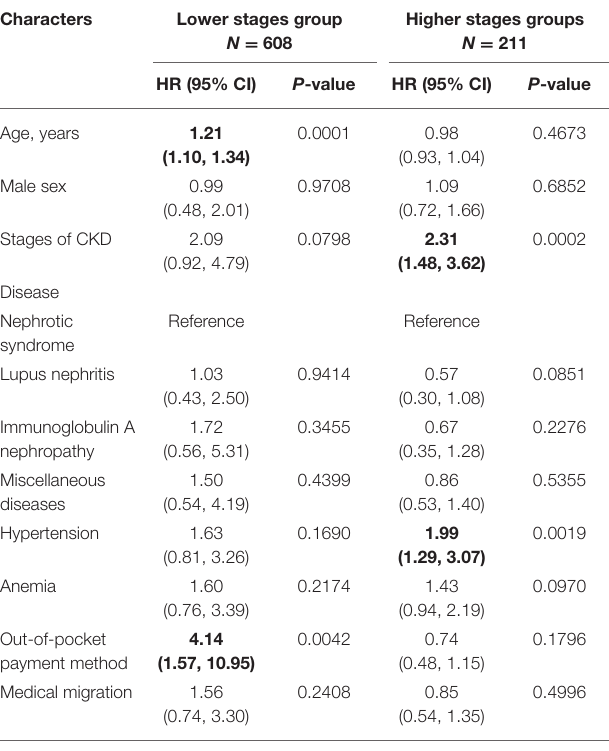
TABLE 3 | Multivariate COX regression assessing the association between baseline characters and progression to CKD stage 5.